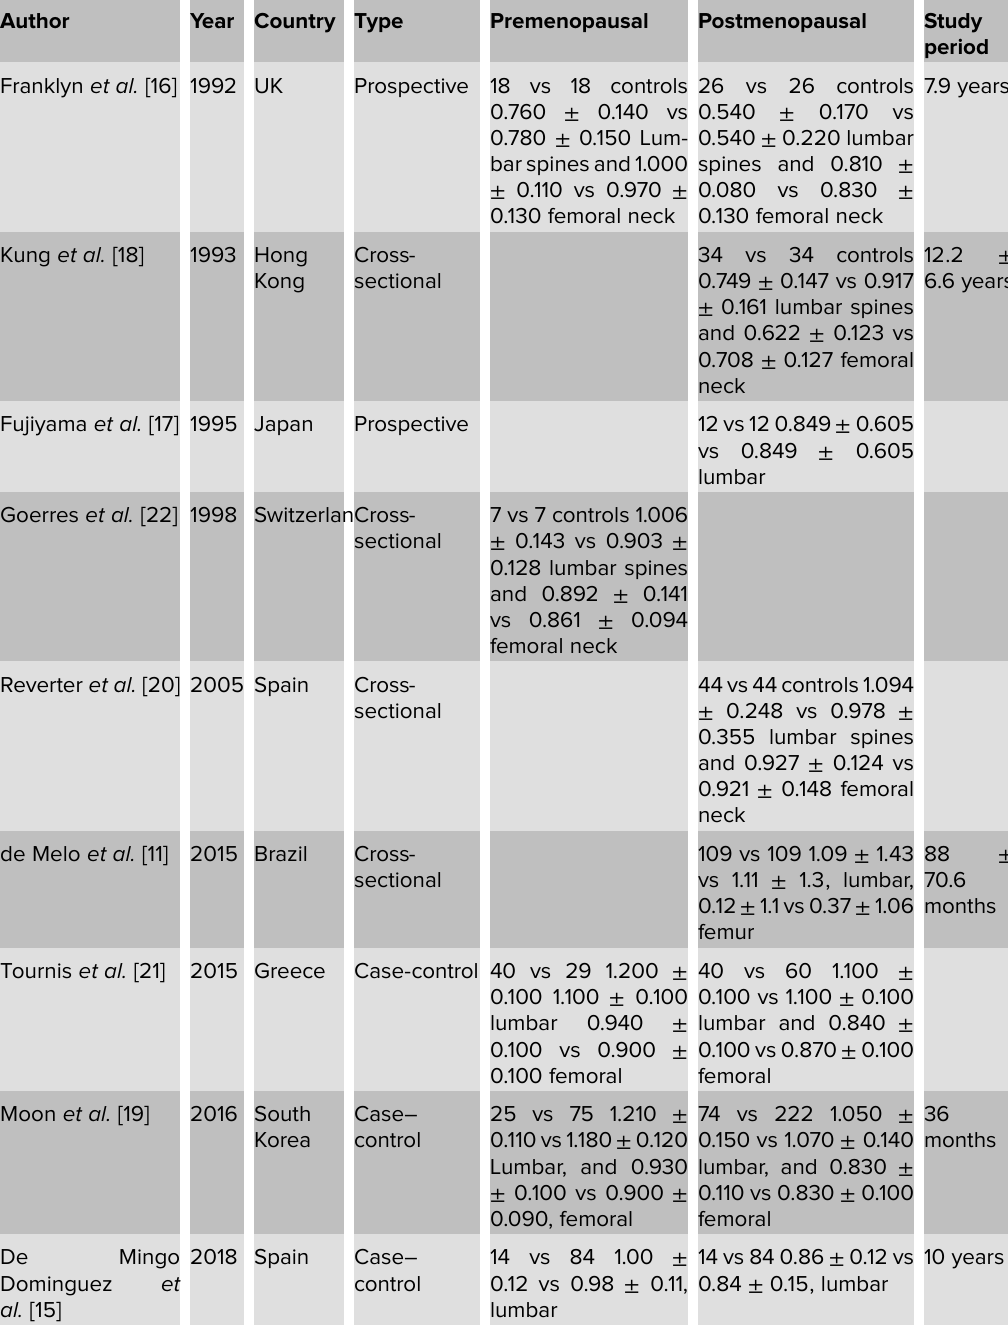
Table 3: TSH suppression for differentiated thyroid carcinoma and bone mineral density among